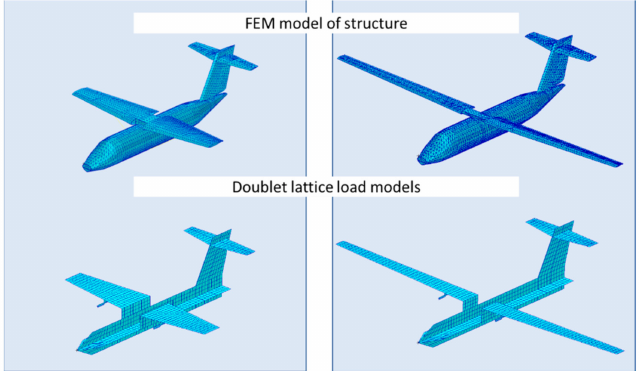
Figure 9. Numerical models of boundary configurations of the